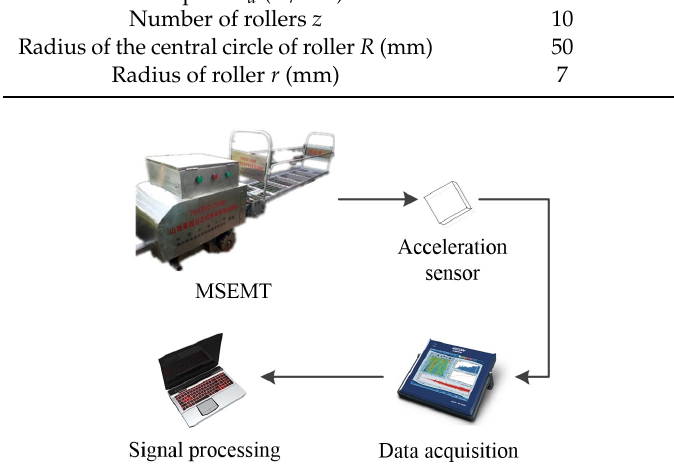
Figure 9. Test system.